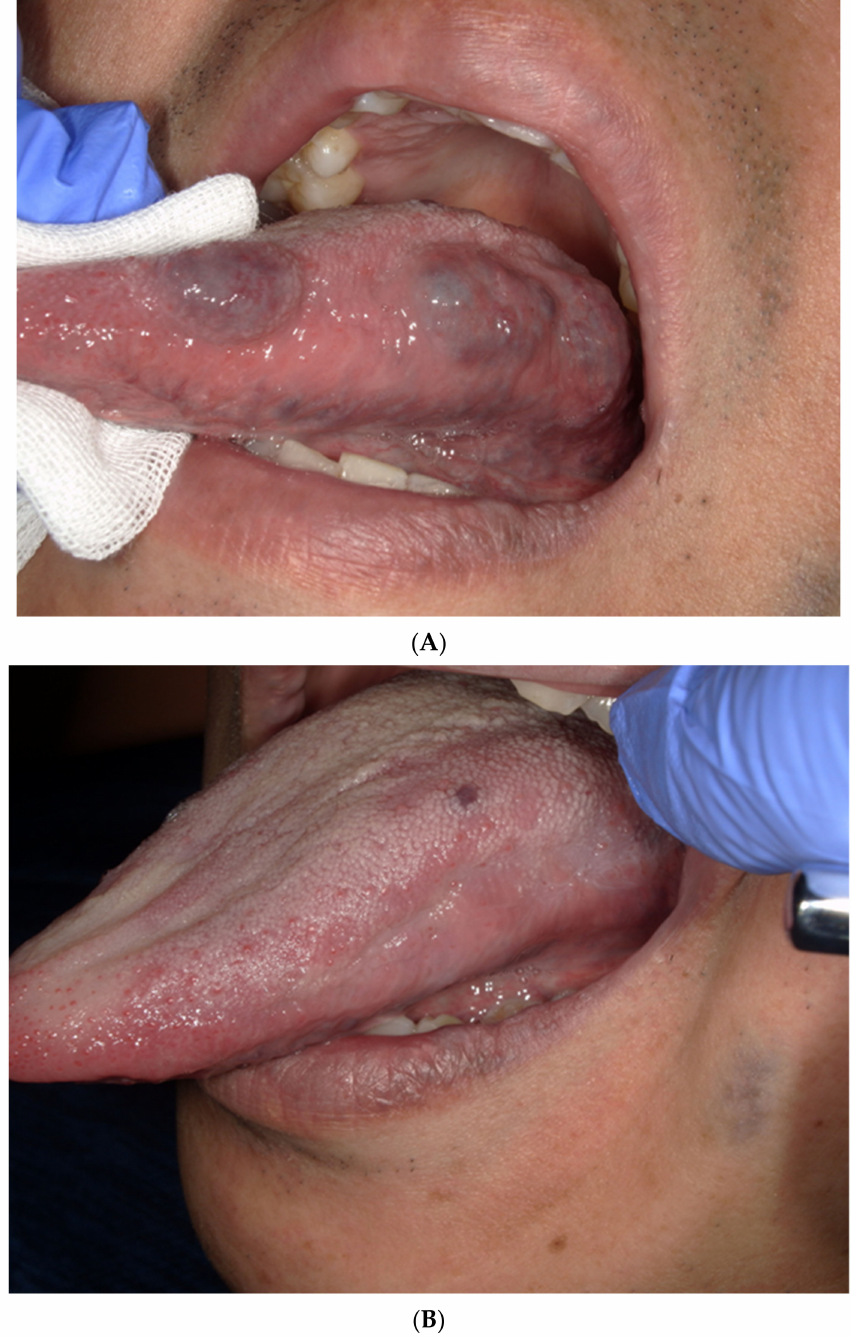
Figure 2. ( A ). The vascular malformation before sclerotherapy. ( B ). An image of a patient with a complete response after